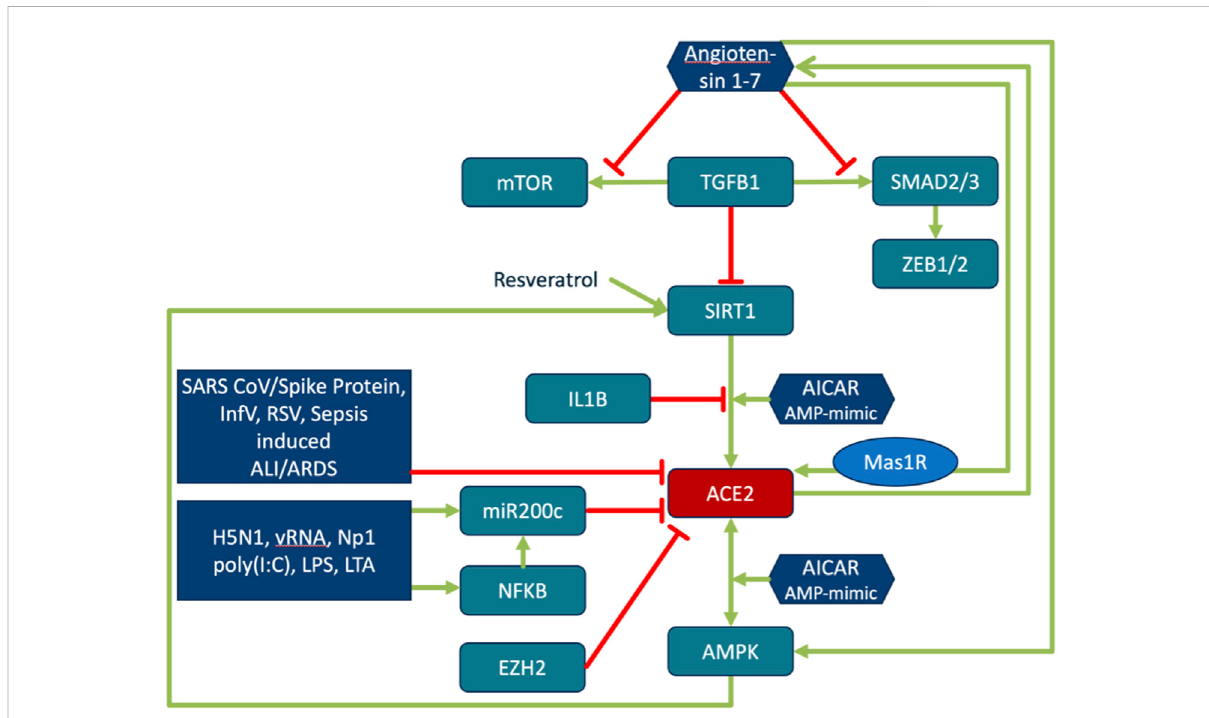
FIGURE 4 Regulation of ACE2 expression and its activity. Regulation of ACE2 is closely interwoven with energy sensing, in fl ammatory processes and ageing. TGF β downregulates ACE2 expression in a SIRT1-dependent manner. SIRT1 activator, SRT1720, restores the ACE2 expression. ACE2/Ang (1 – 7)/MasR are decreased in pulmonary fi brosis and negatively correlate with TGF β expression. Ang (1 – 7) directly inhibits TGF β -induced phosphorylation of SMAD2 and SMAD3 and mTOR, and suppresses the expression of the downstream target genes of TGF β /SMAD signaling (ZEB1, ZEB2, TWIST, and SNAIL1)(Shao etal., 2019).Activationof theenergy status sensing AMPK byAMP mimicAICARincreases phosphorylationof ACE2andSIRT1dependentexpressionofACE2.PhosphorylationofACE2enhancesitsstabilityandactivity(Zhangetal.,2018).ACE2inturnactivates AMPK.PhosphorylationofAMPKisreducedinACE2knock-out,whileAng(1 – 7)activatesAMPK.ResveratrolandAng(1 – 7)increaseACE2expression. SIRT1 antagonist and Mas antagonist block thiseffect (Liu Y.et al., 2019).SIRT1 binds to the ACE2 promoter.Binding is increased by AICAR treatment and decreased by IL1 β (Clarke et al., 2014). ACE2 activation by SIRT1 leads to increased levels of Ang (1 – 7) (Yacoub et al., 2014). The compound Resveratrol induces SIRT1-dependent upregulation of ACE2 (Moran et al., 2017). The role of miR200c in this context is explained in the sections on miR200c function and the reciprocal regulation of ACE2 and